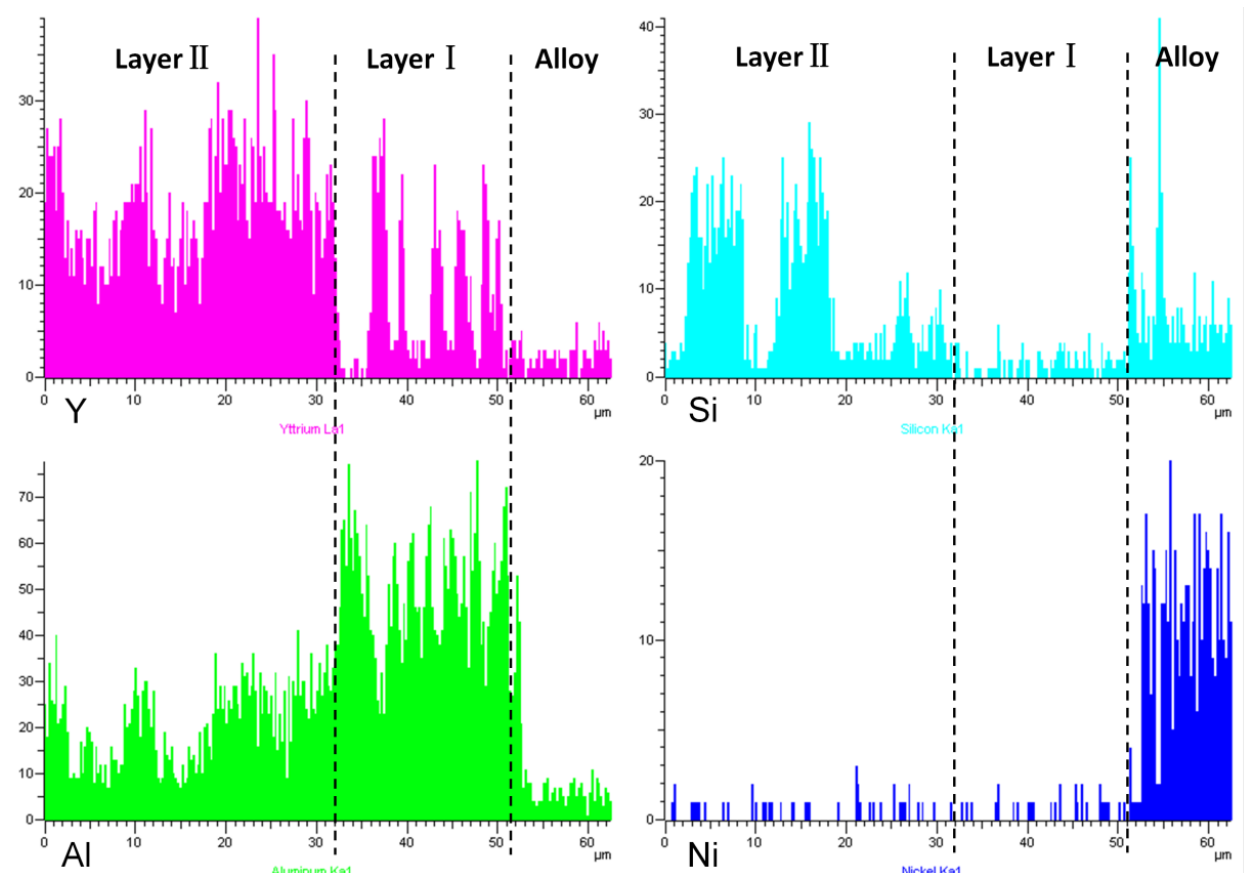
Figure 3. The EDS line scan of interfacial reaction layer between DD6 alloy and Y 2 O 3 mould.